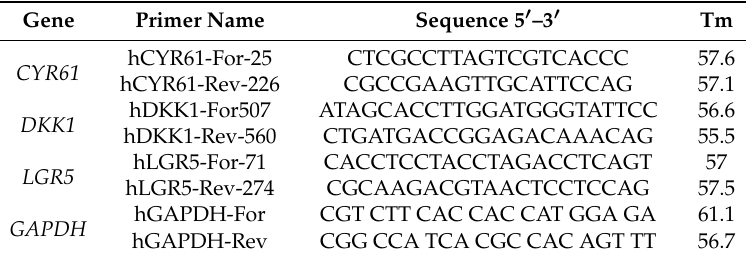
Table 2. Primers used for